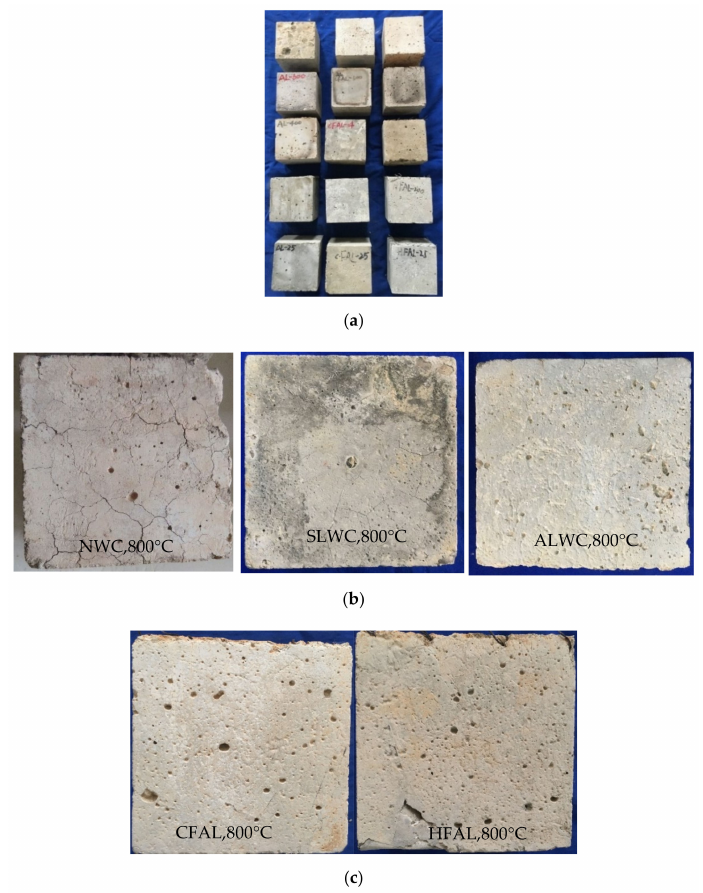
Figure 4. Visual inspection of specimens after exposure to high temperatures: ( a ) the color change of concrete surface after exposure to high temperatures; ( b ) surface cracks of the non-fiber concrete specimen after exposure to 800 ◦ C; ( c ) surface cracks of the added-fiber concrete specimen after exposure to 800 ◦ C.